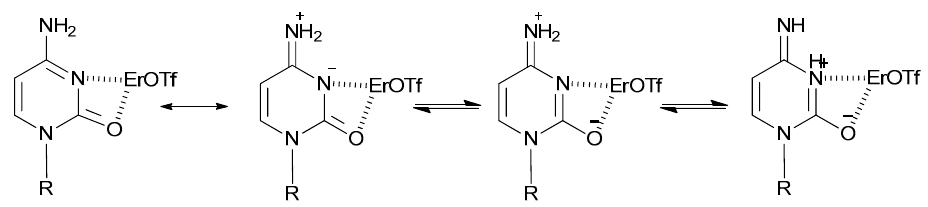
Figure 2. Diagram of tautomeric forms of cytosine ‐ Er(III) coordinate.